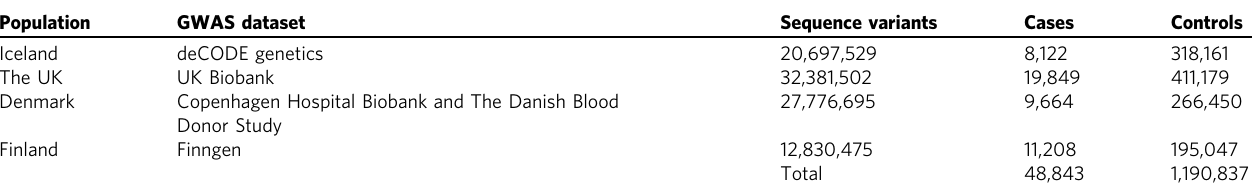
Table 1 Summary of the GWAS datasets in the CTS